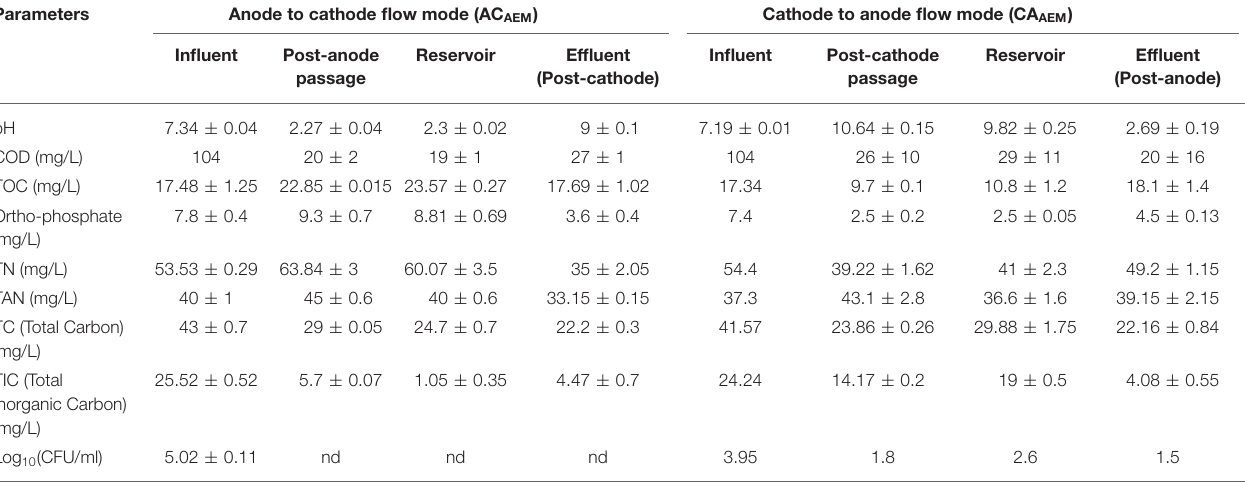
TABLE 3 | Variation in selected wastewater parameters as the feed flows through the chambers of the ECR in experiments AC AEM and CA AEM .